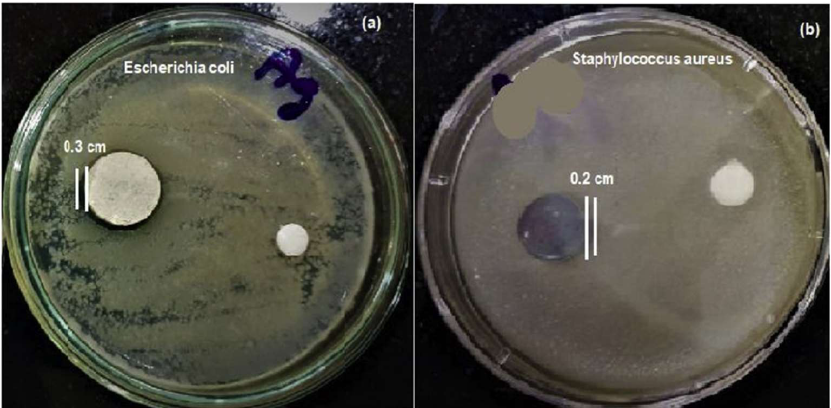
Figure 5. Demonstration of antimicrobial activity of HAp and Ag doped HAp composites against E. coli (Gram-negative) ( a ) and S. aureus (Gram-positive) ( b ) bacteria [261]. The photograph shows that Ag-doped HAp inhibits S. aureus bacteria more effectively than E. coli